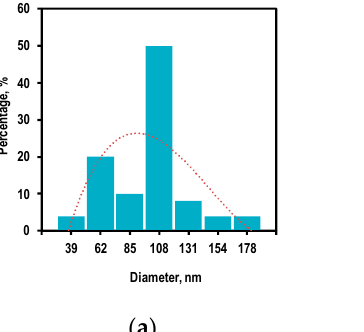
( c ) Figure 7. SEM images of ZnO nanopowders obtained by the PECVD method at various tempera-